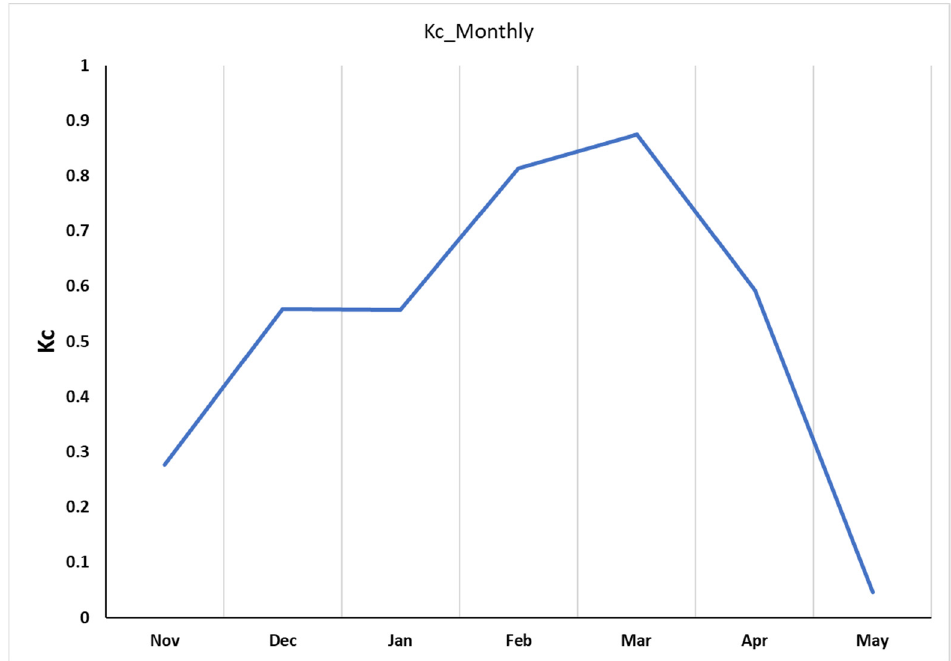
Figure 8. Monthly average crop coefficient (Kc) based on ground measurements of meteorological and energy balance stations.